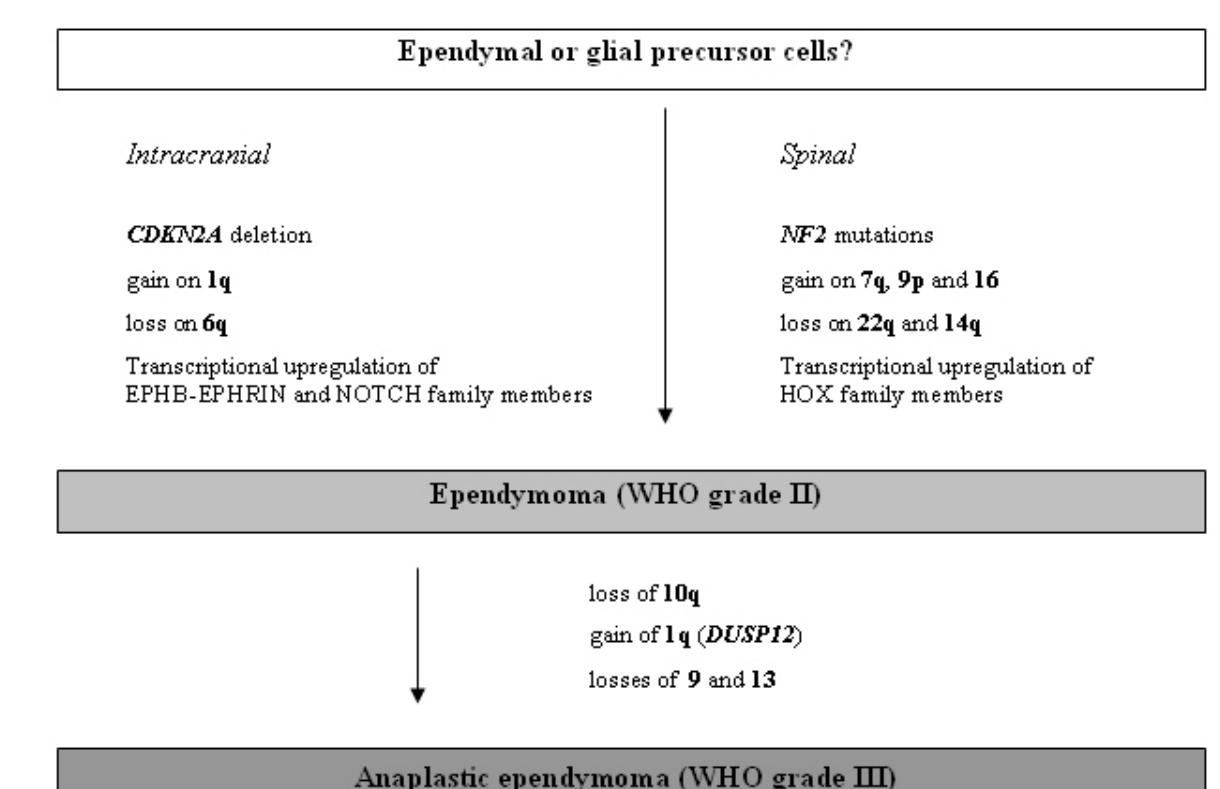
Figure 5. Schematic representation of the molecular pathogenesis and progression of ependymal